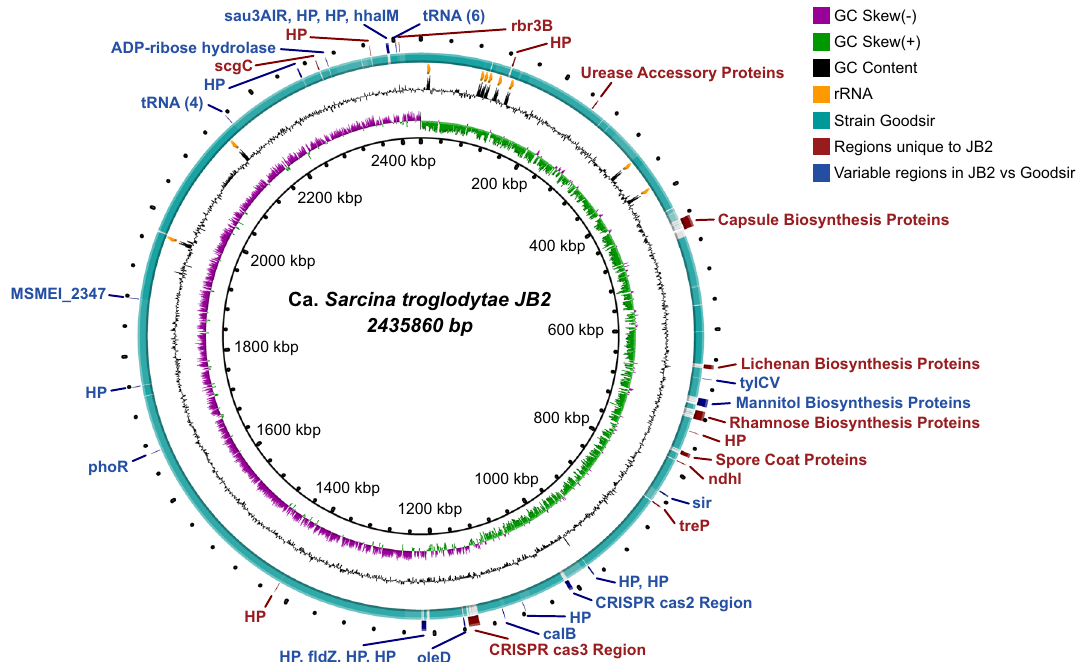
Fig. 8 Whole chromosome comparison of “ Ca . Sarcina troglodytae ” isolate JB2 compared to the type strain S. ventriculi “ Goodsir ” . Red: regions which are unique to JB2. Blue: different ORF sets in the same relative region in JB2 and Goodsir. Teal: 90 – 100% identity gradient between JB2 and Goodsir (Goodsir chromosome sequence is based on a manually scaffolded